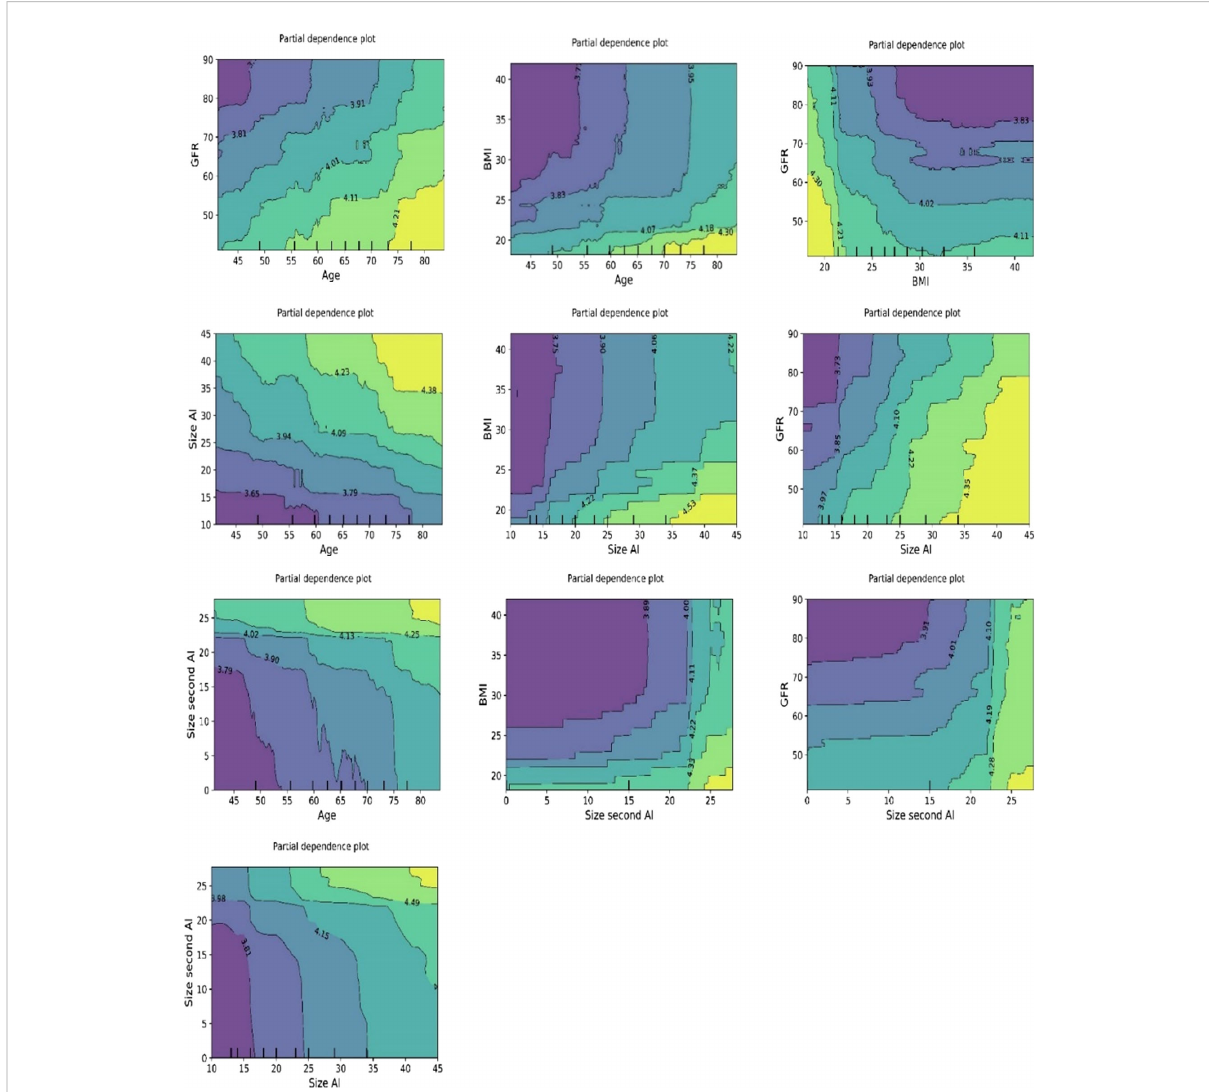
FIGURE 7 Bivariate plots of ln-transformed cortisol DST developed using the ML model random forest. The three plots on the upper “ row ” of plots show the associations of ln-transformed cortisol DST to two of the variates age, BMI, and eGFR. The associations of two of these to ln-transformed cortisol DST seem to be